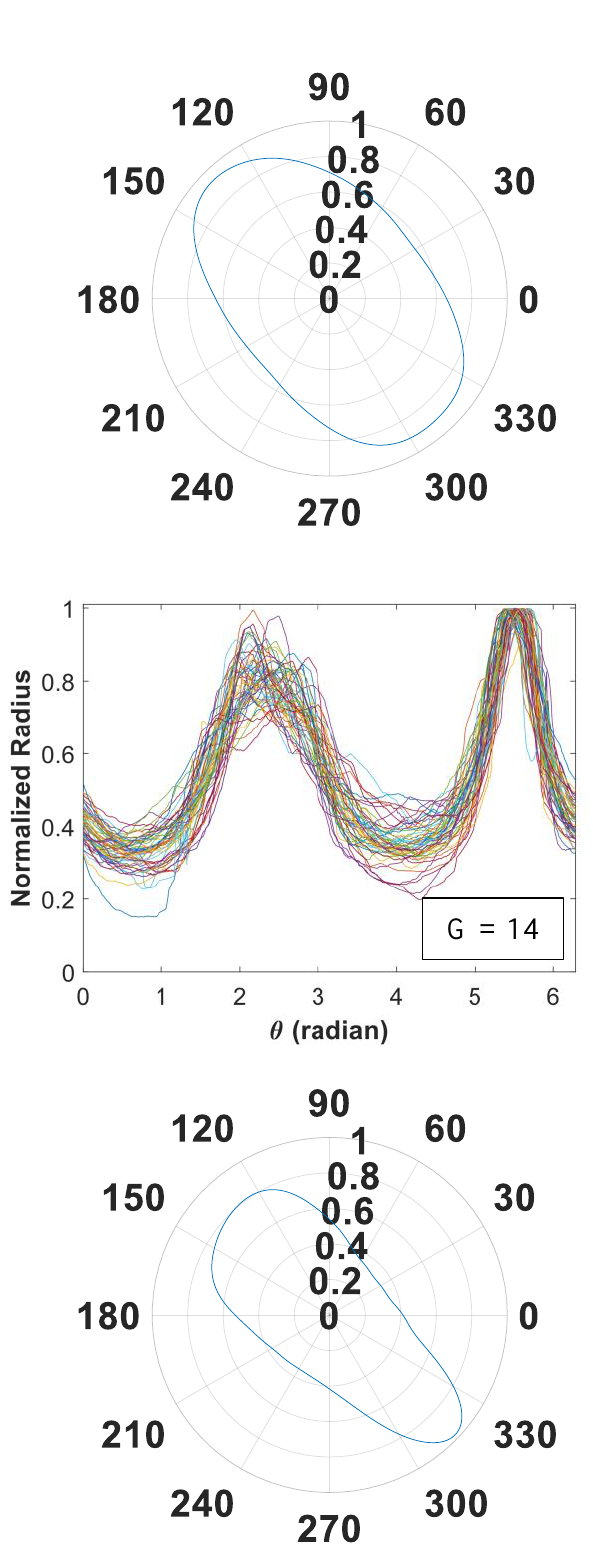
Figure 5. Signature curves within each cluster are presented in the order by rows (cluster 1 to 14).